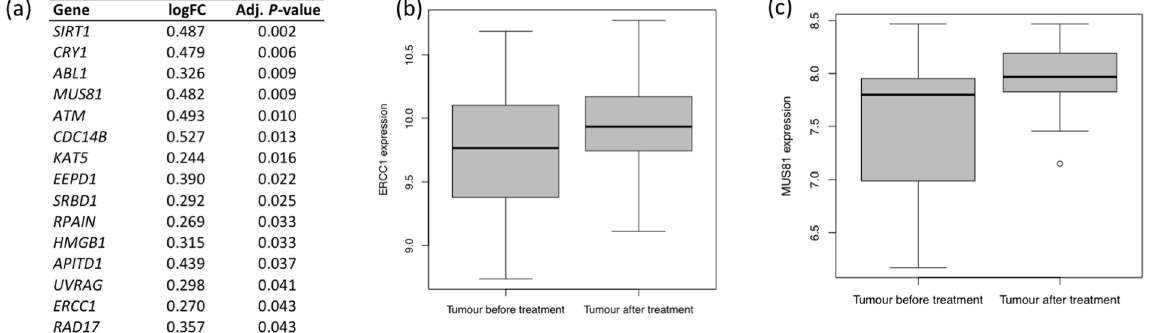
Figure 1. Expression of DNA repair genes in EAC tissue following two cycles of oxaliplatin-fluorouracil chemotherapy. ( a ) Significantly increased expression ( P values adjusted for multiple testing < 0.05) for log fold- change (FC) of 15 genes including ERCC1 and MUS81 . ( b , c ) Significant changes shown by box and whisker plot for: ( b ) ERCC1 mRNA expression (logFC 0.270, adjusted P = 0.043); ( c ) MUS81 mRNA expression (log FC = 0.482, adjusted P = 0.009).